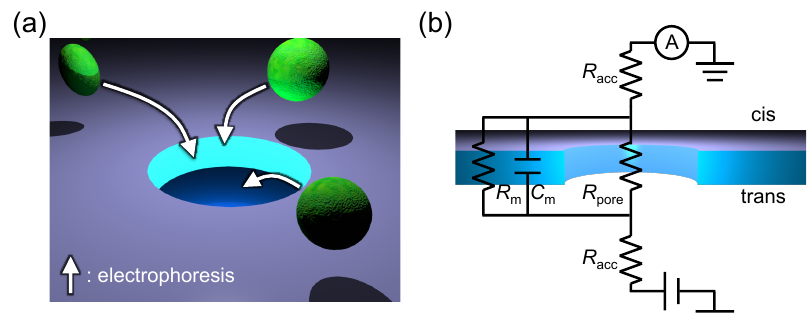
Figure 1. Schematic illustrations of a nanopore device. (a) Schematic illustration of analyte translocations by electrophoresis around a nanopore. As the potential drop is localized inside and around a nanopore, only analytes around the nanopore entrance can be detected. (b) Equivalent circuit of a nanopore device. R ass , R pore , R m , and C m correspond to the access resistance, the pore resistance, the membrane resistance, and the membrane capacitance, respectively.